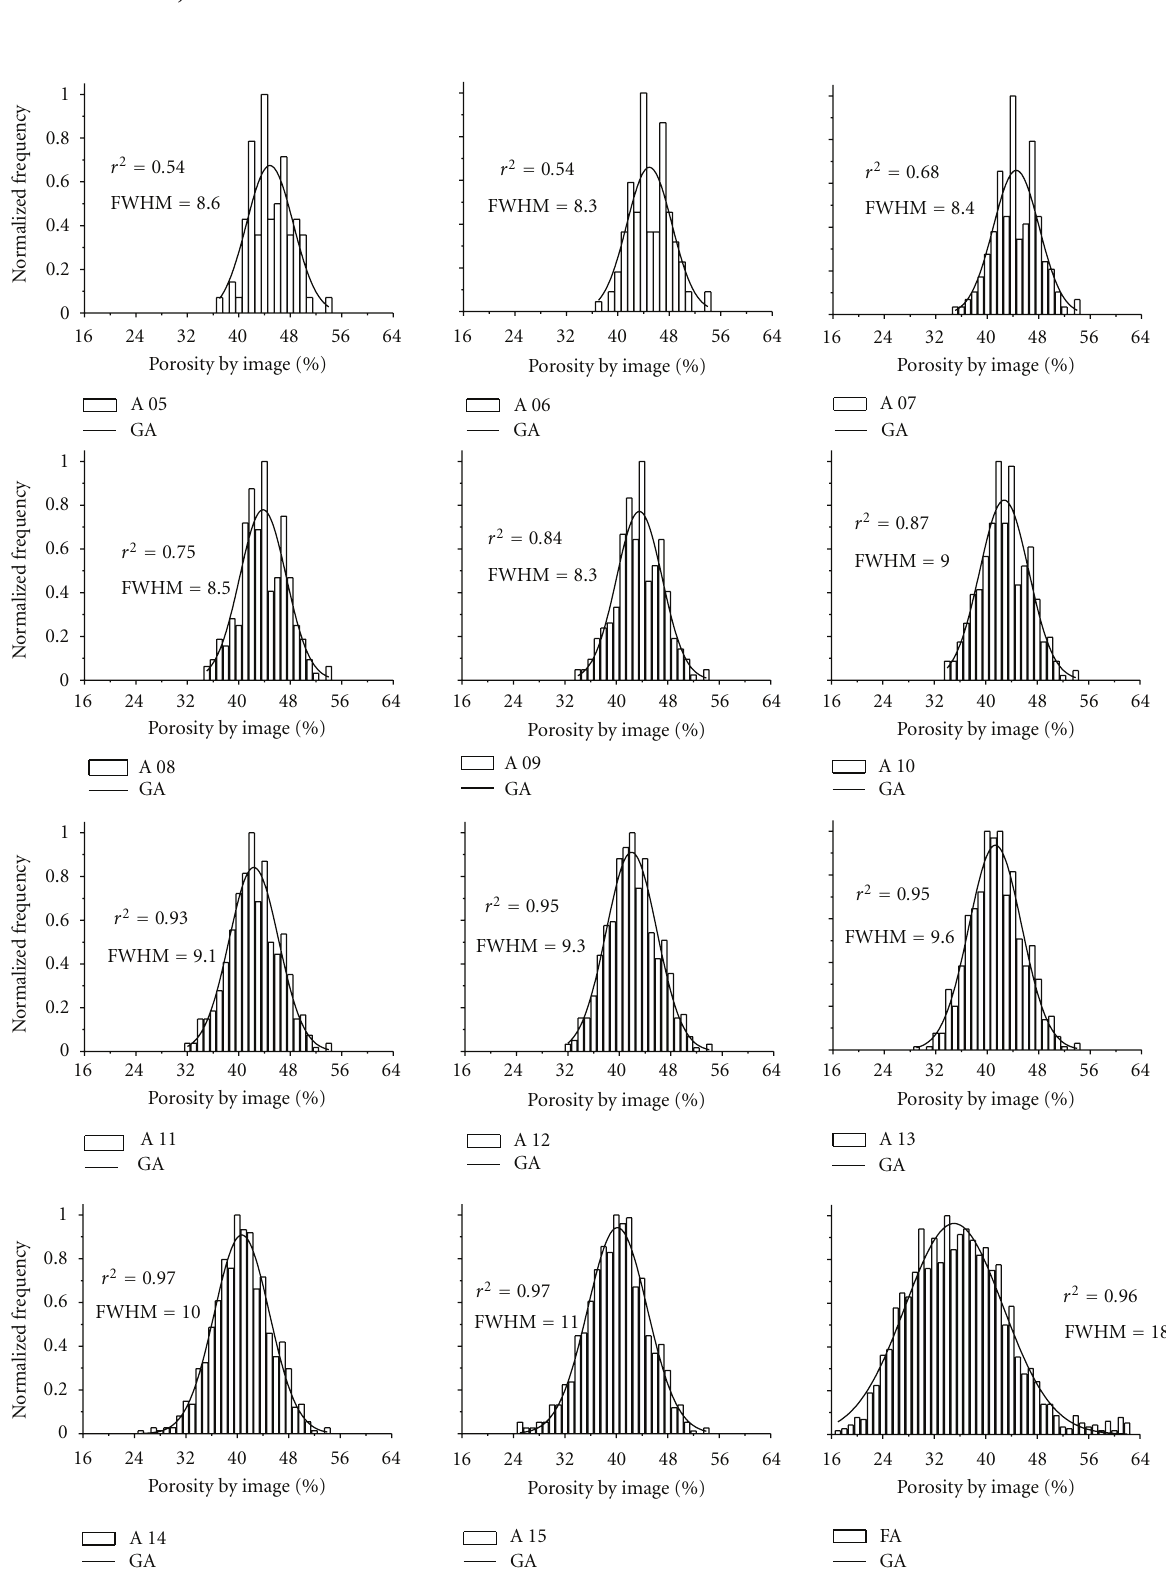
Figure 8: Normalized frequency of the porosity by image (%) from the 5th selected area in the sample 10 (S 10). A 05, A 06, ... , and A 15 correspond to the sequence of quadrangular areas selected in the image and free area (FA). GA represents the Gaussian adjustment, r 2 the coe ffi cient of determination, and FWHM the full width at a half maximum of the